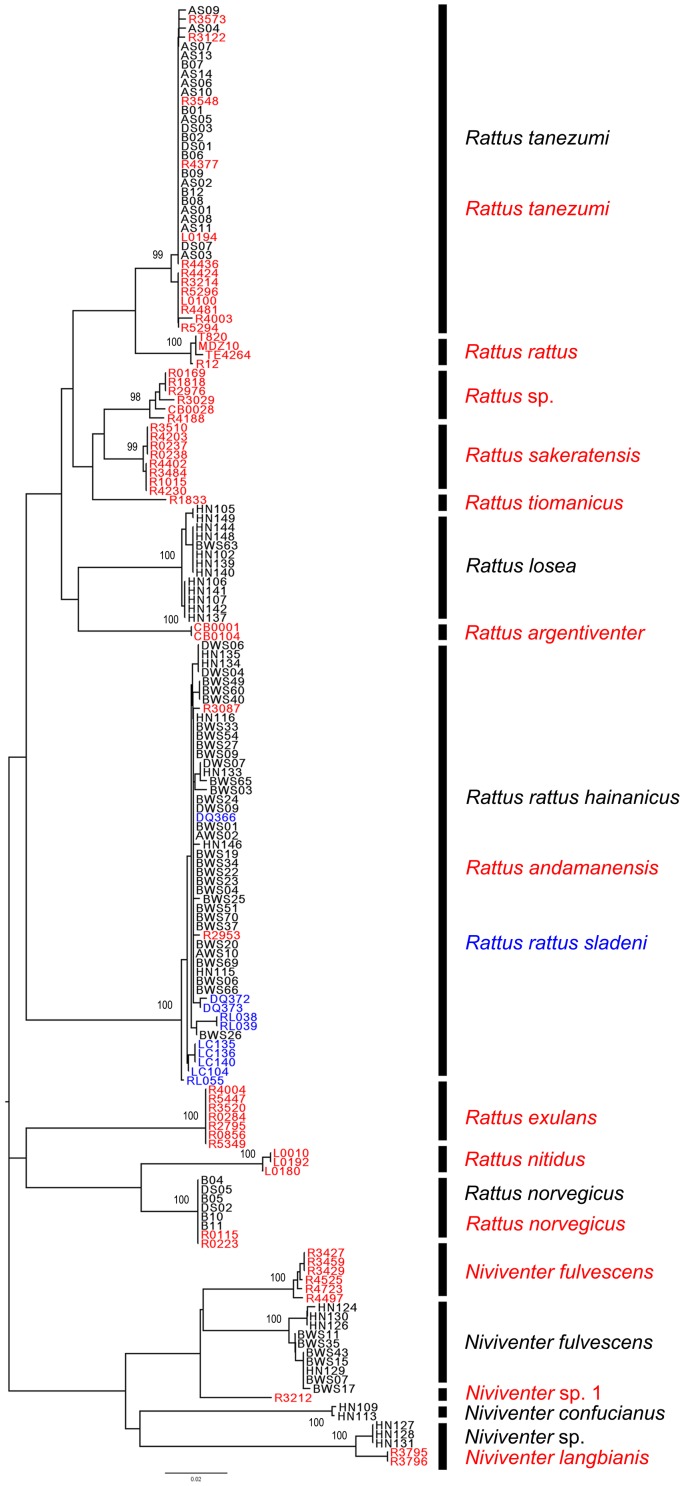
Neighbor-joining tree of COI sequence of Rattus and Niviventer collected from Hainan, Yunnan and Southeast Asia.Samples with black name and species name were collected from Hainan, those with blue name and species name were from Yunnan, and the red from Southeast Asia [21]. Samples separated by small genetic distance (<2%) were labeled with one vertical black bar and regarded as one species. Low bootstrap support value (<90%) on deep branches were not shown.